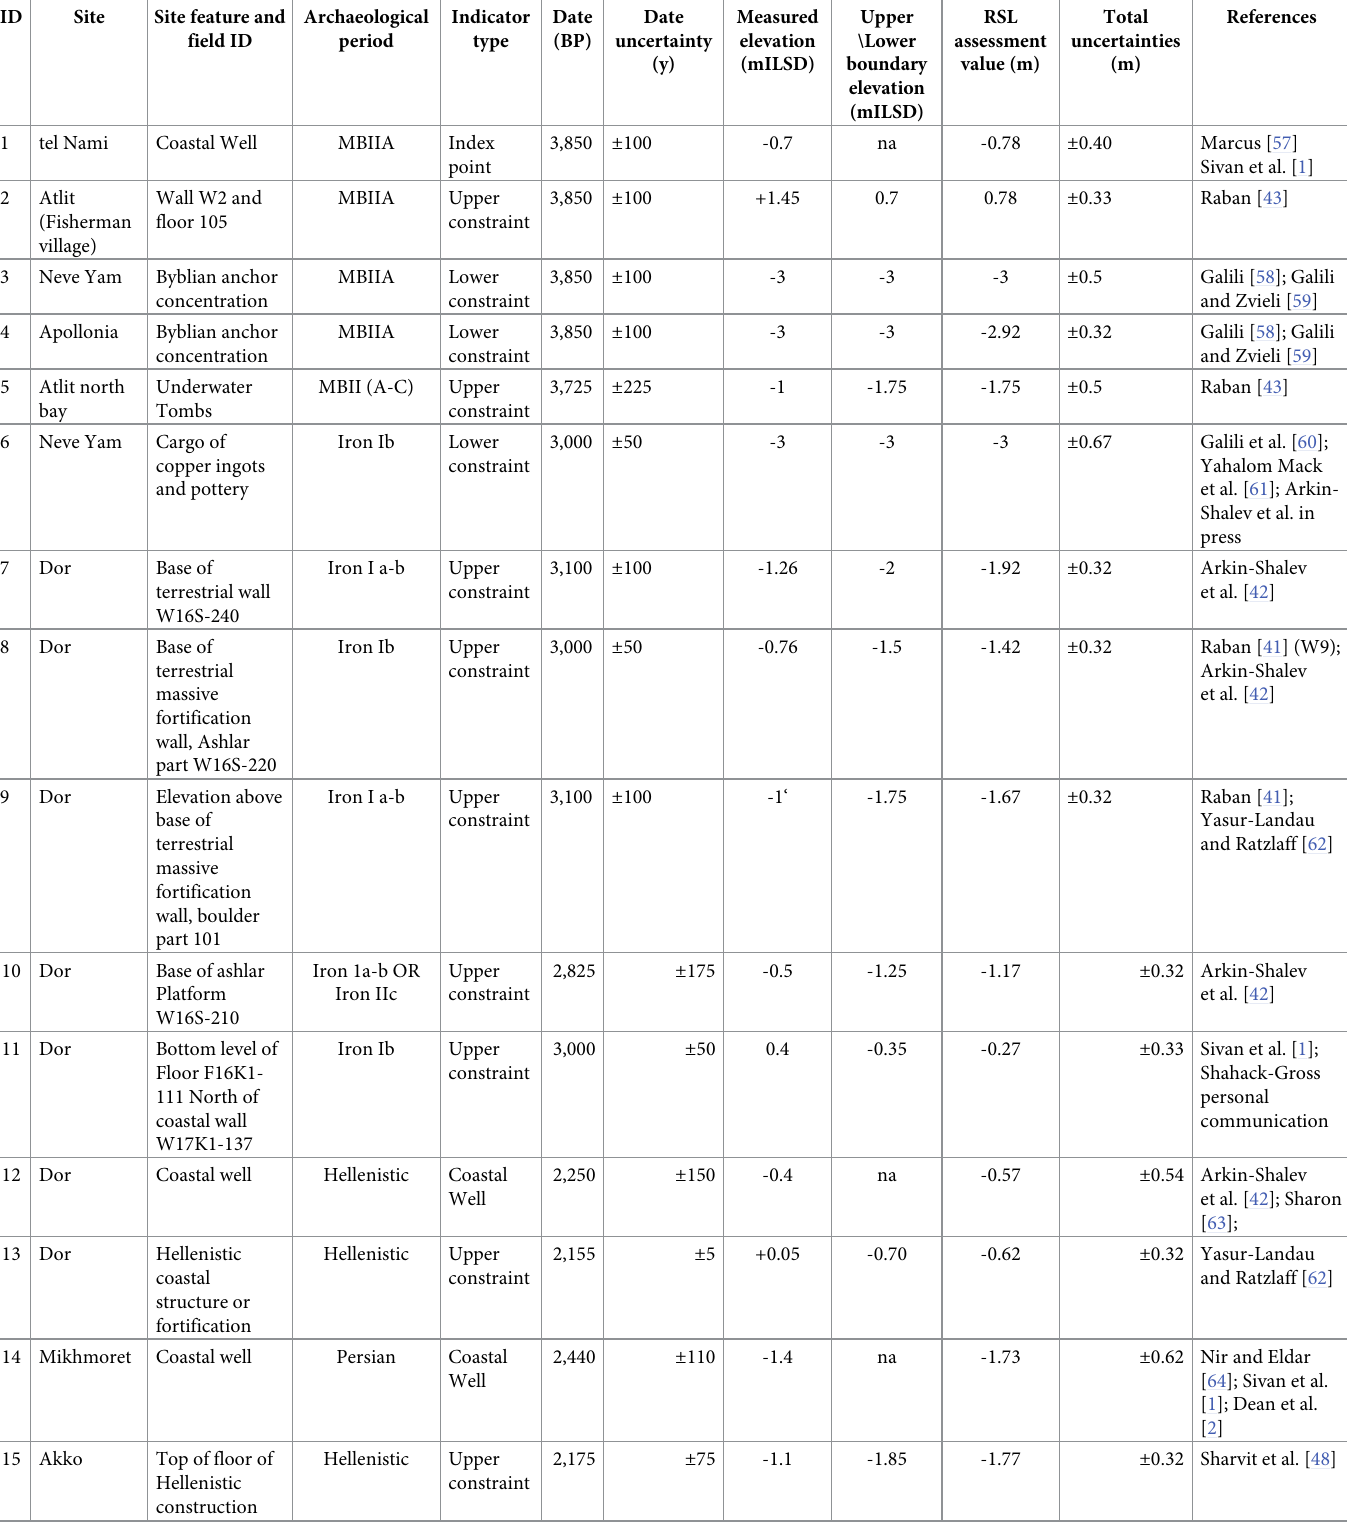
Table 1. The Israeli archeological features used in the current study for assessing the relative sea level of the Middle Bronze IIA to Roman period. ID